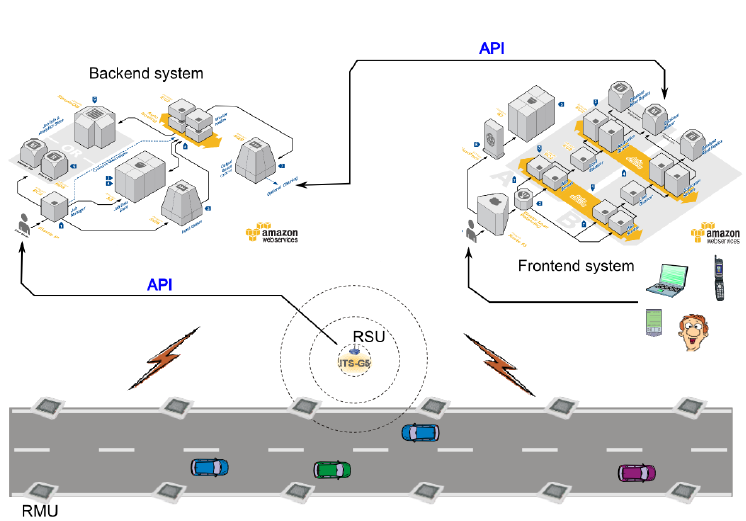
Incoming traffic load on the backend system as a function of the number of